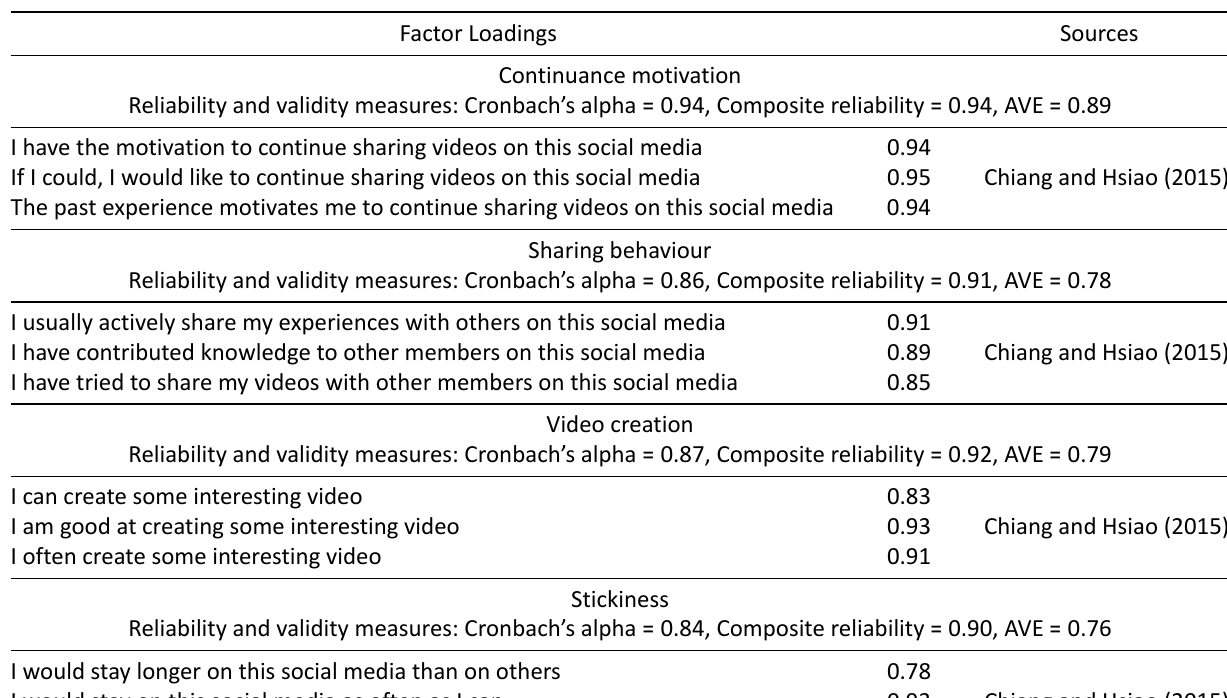
Table 1. Items, factor loading, reliability, and validity.